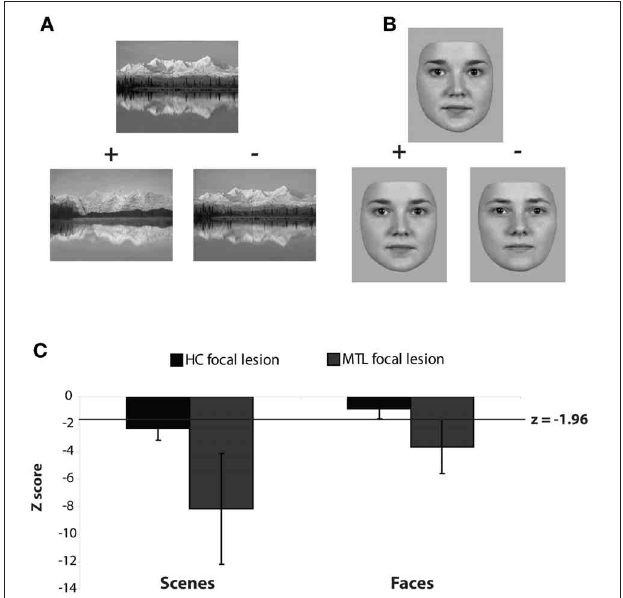
FIGURE 1 | Example (A) Scene and (B) Face trials from the visual discrimination task used in Lee et al. (2005c). On every trial participants indicated which bottom image was most similar to the simultaneously presented top exemplar image. The two bottom images were created from morphing two exemplars. “ + ” and “ − “ indicate correct and incorrect answers, respectively. (C) Z -scores for patients with selective hippocampal lesions (HC focal lesion) and those with broader MTL lesions that included the hippocampus and perirhinal cortex bilaterally (MTL focal